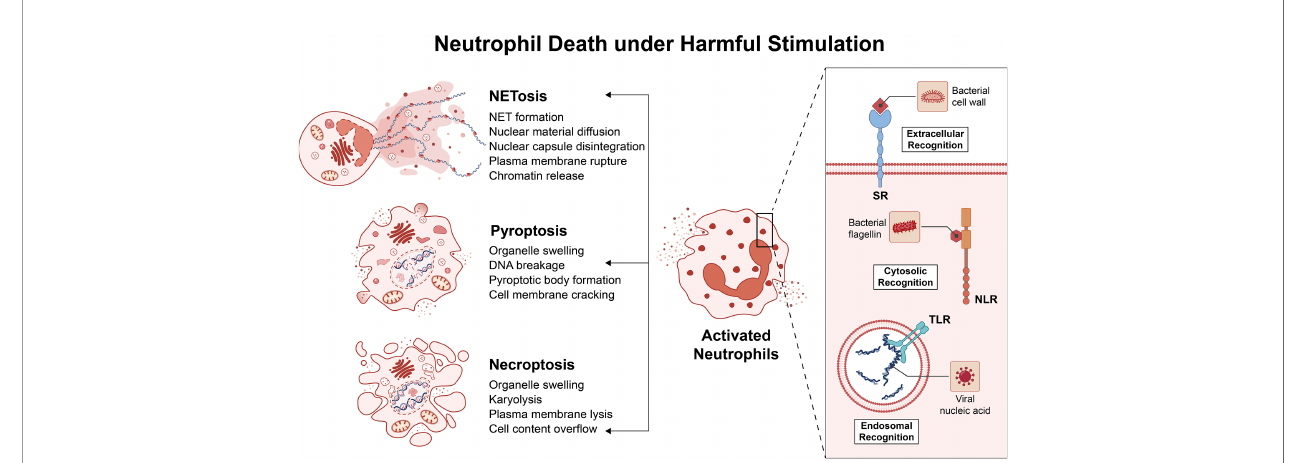
FIGURE 1 | Neutrophil Death under Harmful Stimulation. Neutrophils recognize pathogens through pattern recognition receptors (PRRs). The main PRRs are Toll- like receptors (TLR) or NOD-like receptors (NLR), and there are some other PRRs, such as scavenger receptors (SR). These PRRs can recognize pathogens in the extracellular cytoplasm and endosomes. Neutrophils are activated after recognizing the pathogen and begin to kill the pathogen. The fi nal outcome of an in fl ammatory environment is often: necrosis, pyroptosis, and neutrophils external traps. These death pathways have different characteristics, but all exacerbate the in fl ammatory